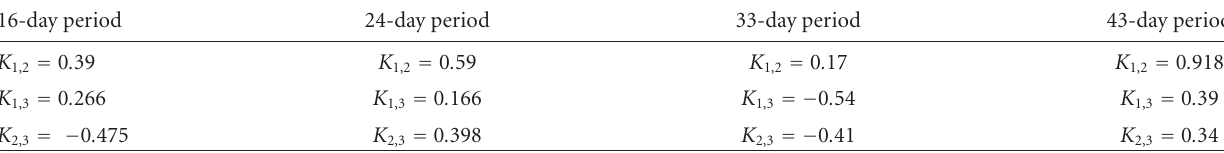
Table 1: Correlation coe ffi cients between occurring oscillations with periods of planetary waves in variation of the temperature parameters and the ionospheric parameter for some